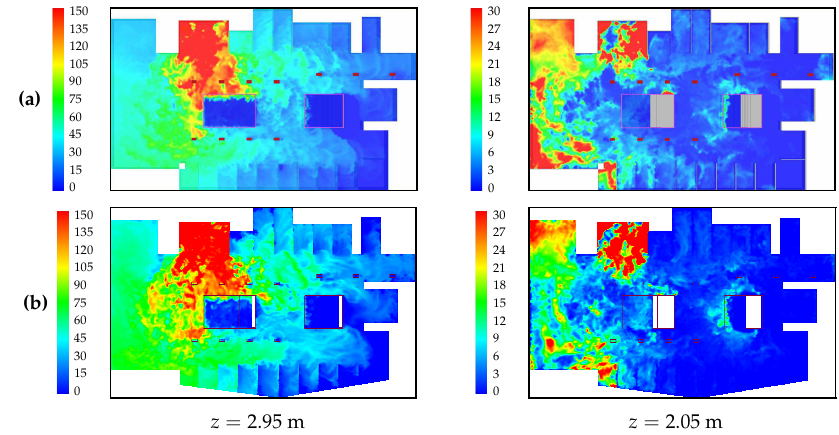
Figure 17. Contours of CO 2 mass fraction ( Y CO 2 × 10 4 ) at t = 90 s and heights z = 2.95 m (left column) and z = 2.05 m (right column), obtained as in Figure 13. (a) FDS; (b) FLUENT.